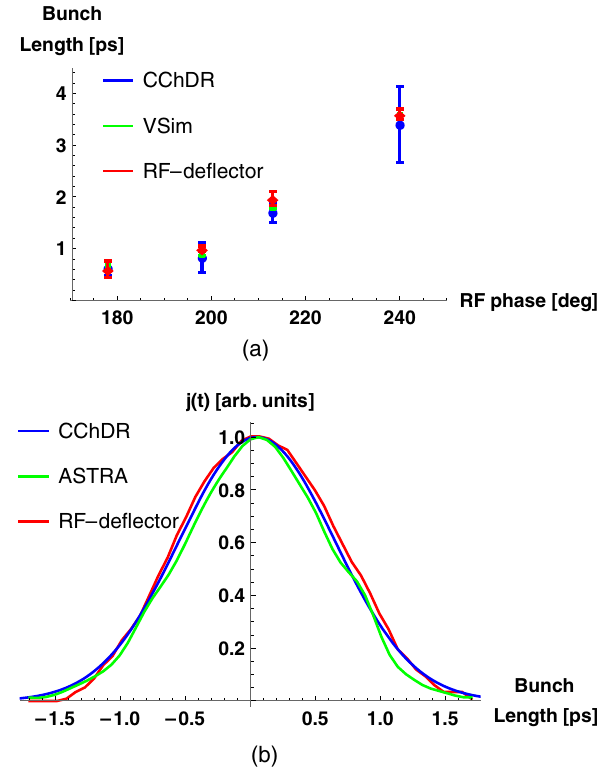
FIG. 9. Top figure (a): Direct comparison between the rms bunch length of Gaussian bunches as measured with the rf- deflector and by detection of CChDR. Simulation results are also reported. Bottom figure (b): Comparison among bunch profiles obtained with CChDR, with rf-deflector and simulated with ASTRA, corresponding to the bunch length ∼ 0 . 6 ps rms in Fig. 9(a).